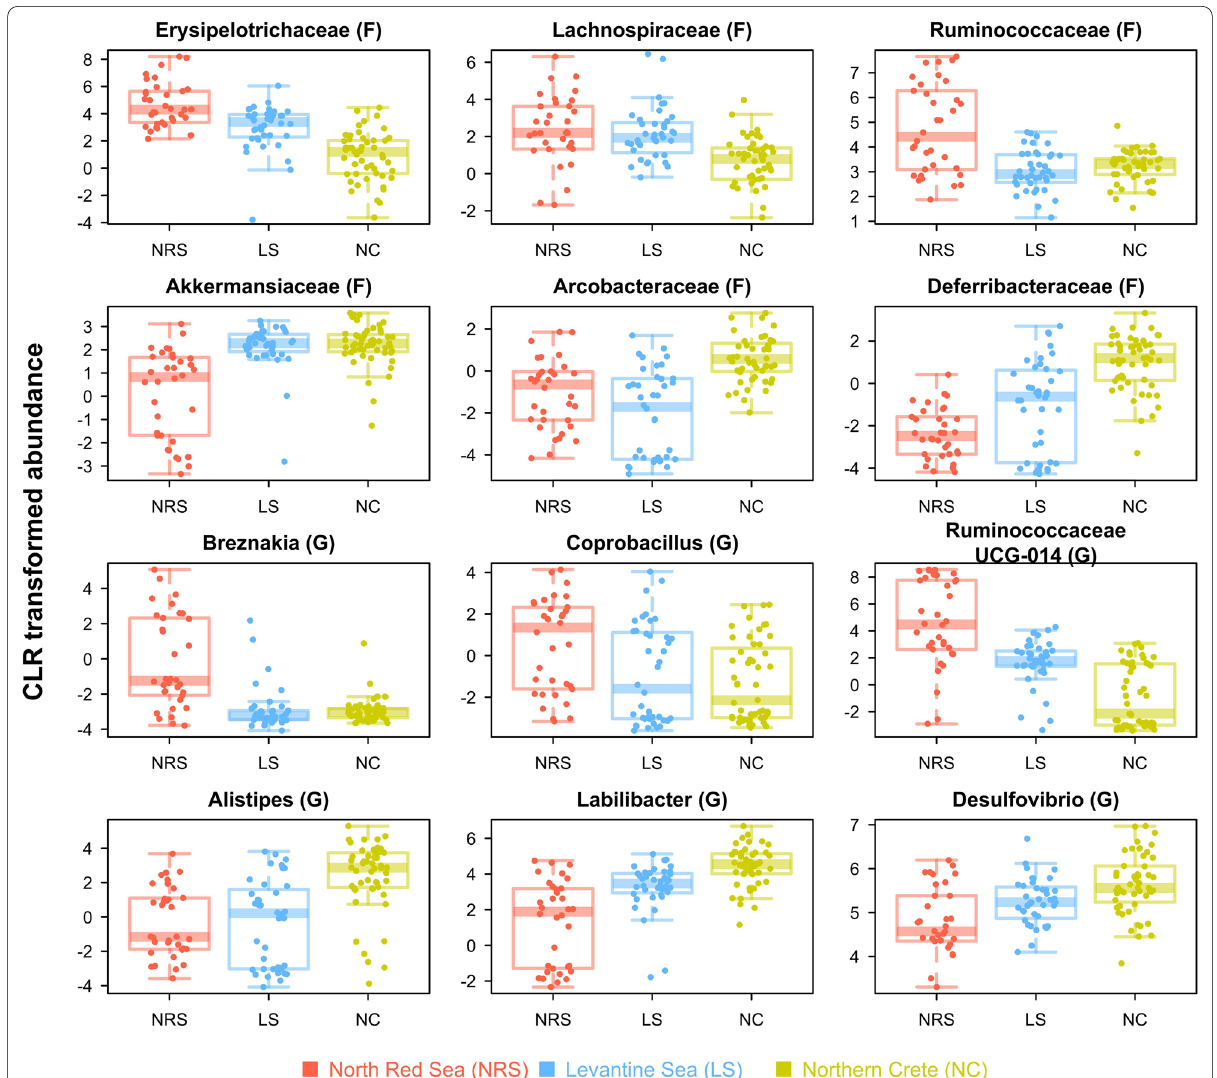
Fig. 3 Bacterial taxa with the highest contrast in abundance in the gut of S. rivulatus across the 3 regions. Names of taxa are provided at top of each panel with letter in parentheses for taxonomic level (F: Family and G: